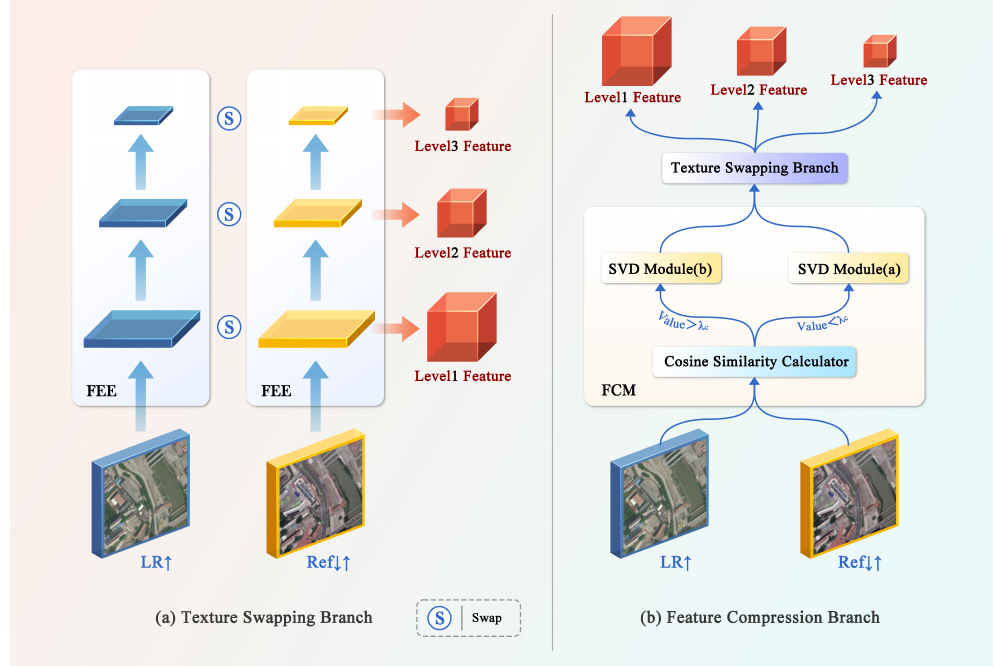
Figure 2. The architecture of the proposed modules. ( a ) texture swapping branch; ( b ) feature compression branch (FCB). The FCB is composed of a feature compression module (FCM) and texture swapping branch. FCM employs SVD to adaptively offer complementary information between the LR and Ref images. The texture swapping branch furnishes multi-level features, which are displayed as Level 1 features, Level 2 features, and Level 3